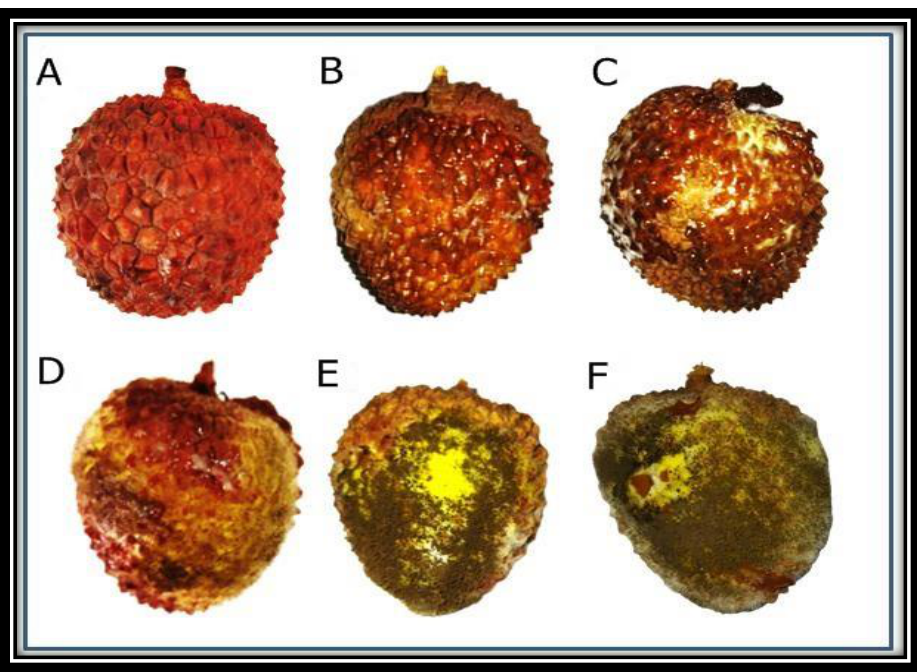
Figure 8. Lychee fruit were infected and treated with different concentrations of ZnO NPs including 1 mg/mL ( A ), 0.75 mg/mL ( B ), 0.5 mg/mL ( C ), 0.25 mg/mL ( D ) and 0.1 mg/mL ( E ). Control plants were not treated with any NPs ( F ). Table 4. After treatment of different concentrations of ZnO NPs on diseased lychee fruit, the disease area is shown here.